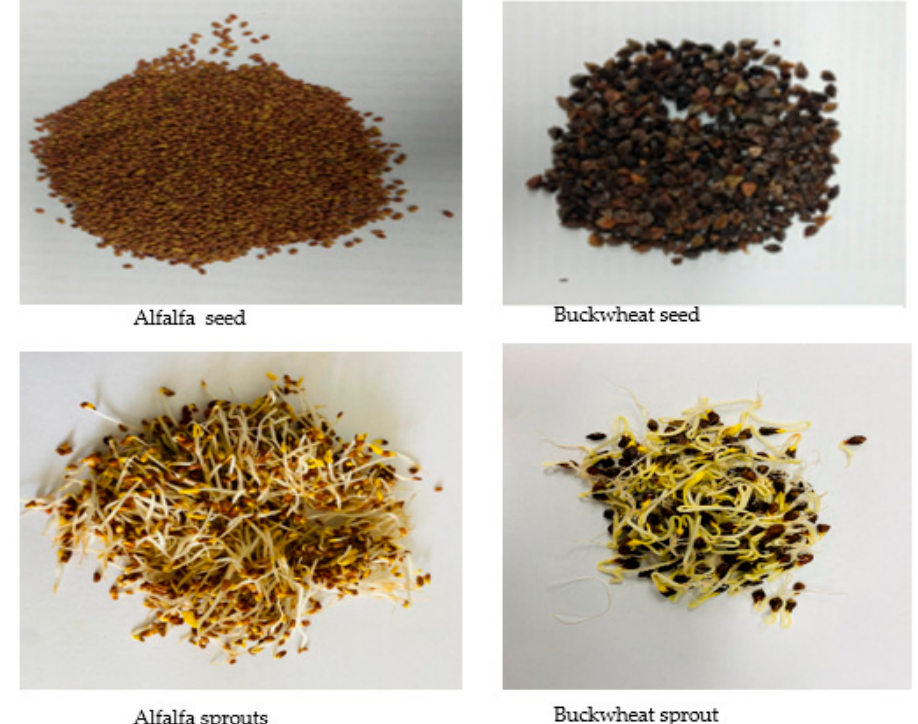
Figure 1. Representatives of alfalfa and buckwheat seeds and sprouts provided by Charm-Chae-One, Ltd. (Jincheon, Chungbuk,